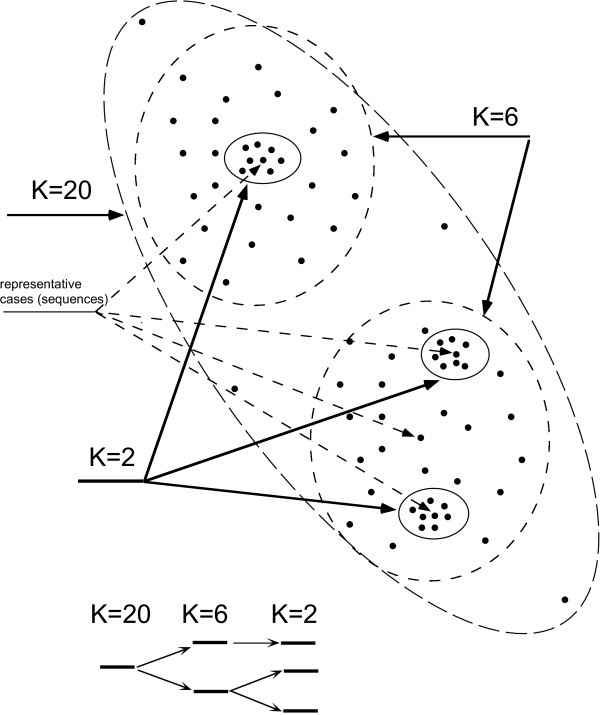
gSPC processing of simulated data using different K. The clusters detected for different K are shown as ellipsoids. On the first level K = 2, three most compact clusters are detected by the algorithm. The representative cases from these clusters will stay for further step of analysis, K = 6. For K = 6 two clusters are detected and, eventually for K = 20 one cluster will be detected. Thus the gSPC algorithm detects embedded clusters. The representative cases are used to restore hierarchical organization of clusters shown at the bottom of the figure. Notice, that for the upper clusters, the same sequence is the representative one for K = 2 and K = 6.